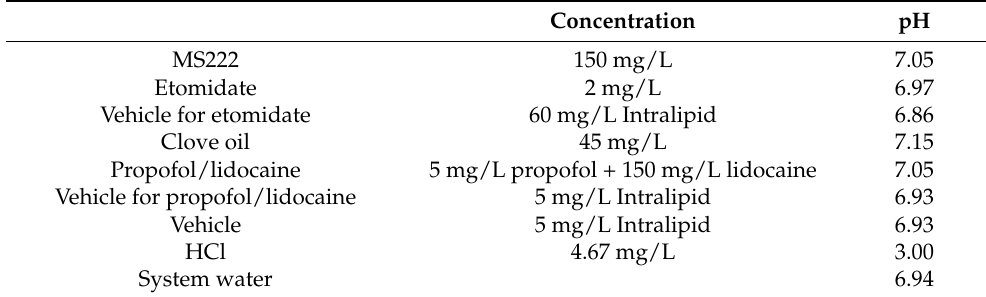
Table 1. The pH of the solutions and the system water used in the study as measured by a pH probe (Inolab, level 1, Xylem Analytics Germany Sales GmbH & Co. KG, Oberbayern, Germany). The solution temperature was 26 ± 1 ◦